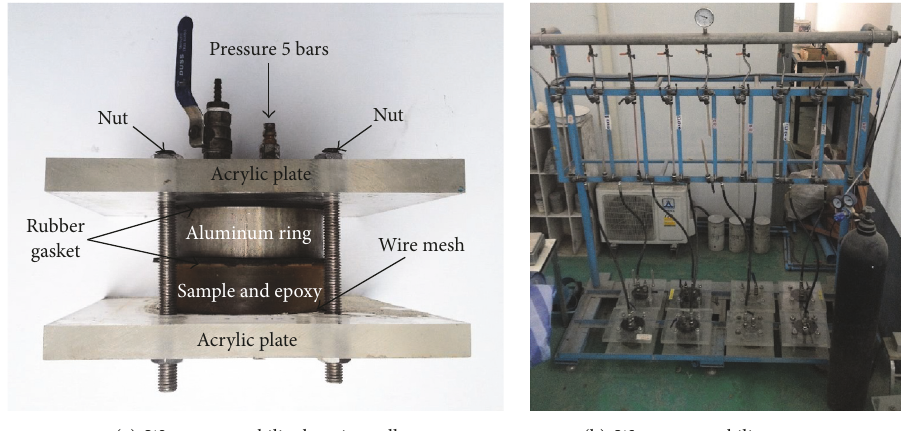
Figure 1: Water permeability coefficient